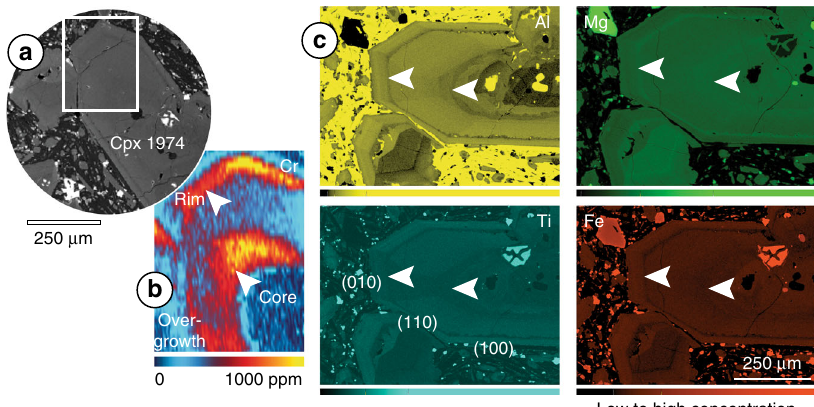
Fig. 2 Comparison between Cr zoning and major element zoning on a clinopyroxene antecryst from the 1974 eccentric eruption at Mt. Etna. a Backscattered electron (BSE) image provides context; the white rectangle marks the location of the Cr map. b Quantitative map of Cr obtained by LA- ICPMS. c Semi-quantitative maps of Al, Ti, Mg and Fe obtained by FE-SEM – EDS. The crystal shows two Cr-rich zones (see white arrows), which could represent two recharge events or alternatively swirling of magma and migration of crystals following complex pathways 5 after one recharge event. The Cr- rich rim is relatively rich in Mg and poor in Fe, but Mg – Fe zoning is weak in the Cr-rich mantle, probably due to diffusive relaxation with storage time 66,67 . Aluminium zoning is sharp, as expected from its slow diffusion 64,65 , and the decoupling between Al and Cr rules out kinetic controls on Cr zoning. The outermost rim of the crystal is de fi ned by a decrease in Cr – Mg and an increase in Al – Ti, as expected from crystallisation under increasing magma cooling rates 41,42 , here linked to fi nal magma ascent and degassing. There is a minor sector zoning effect on (010), slightly depleted in Ti – Al but with general concentrations in major and trace elements similar to other sectors in the